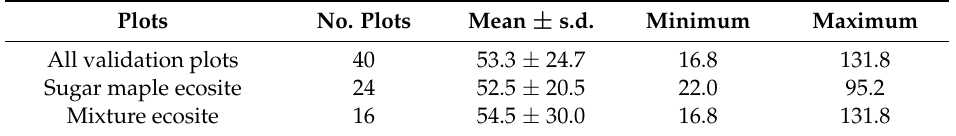
Table 2. Reynolds error index values for all validation plots and for sugar maple and mixture ecosites separately. Lower values indicate a closer match between the predicted and observed stem